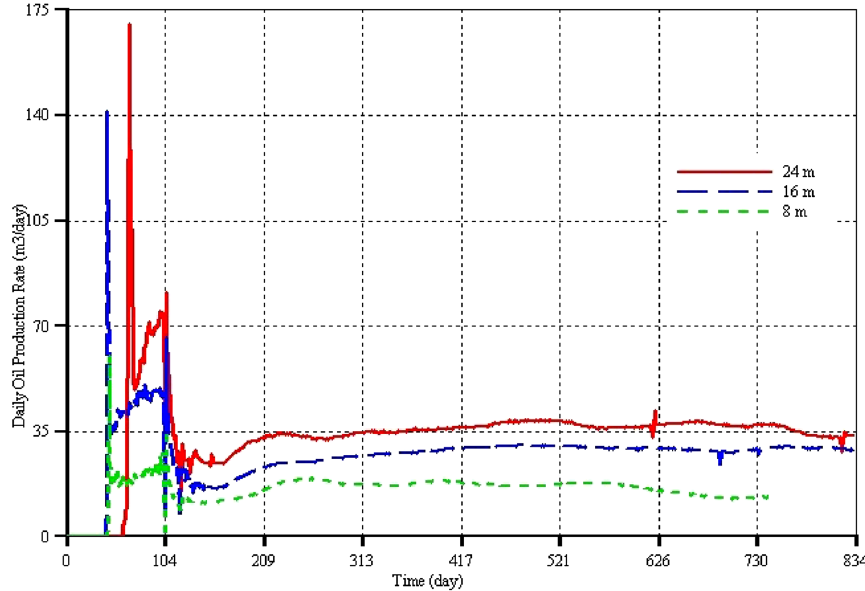
Fig. 6 Oil production rate for